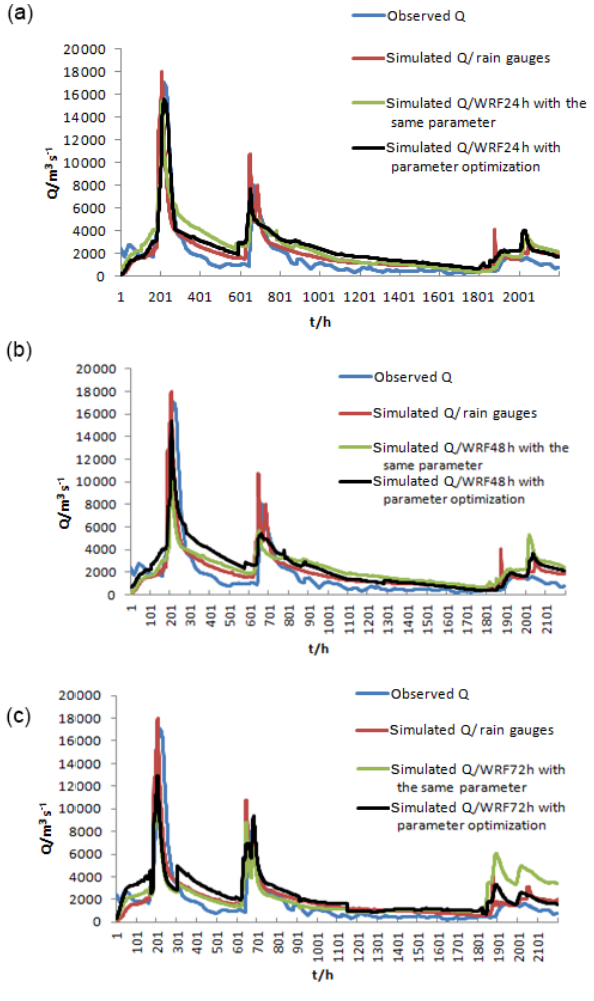
Figure 11. Coupled flood simulation results with re-optimized model parameters (2013). (a) is the simulated result with 24h lead time, (b) is the simulated result with 48h lead time, and (c) is the simulated result with 48h lead time.